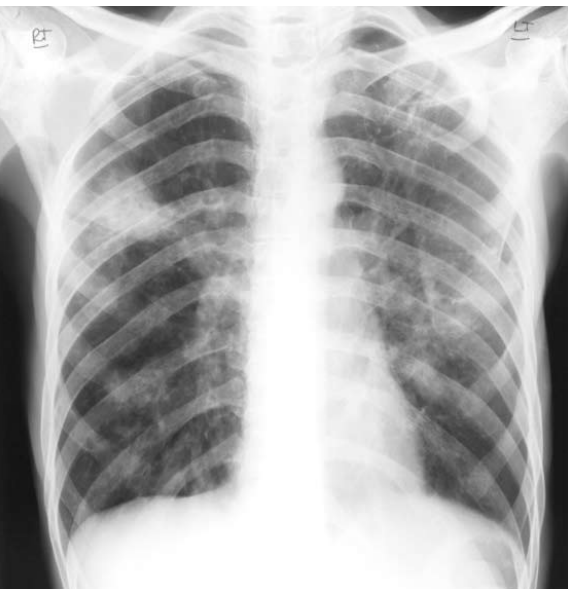
Fig. 1. The chest radiograph in patient 1 demonstrates bilateral multifocal areas of patchy airspace disease, as well as a dominant focal area of density in the right upper